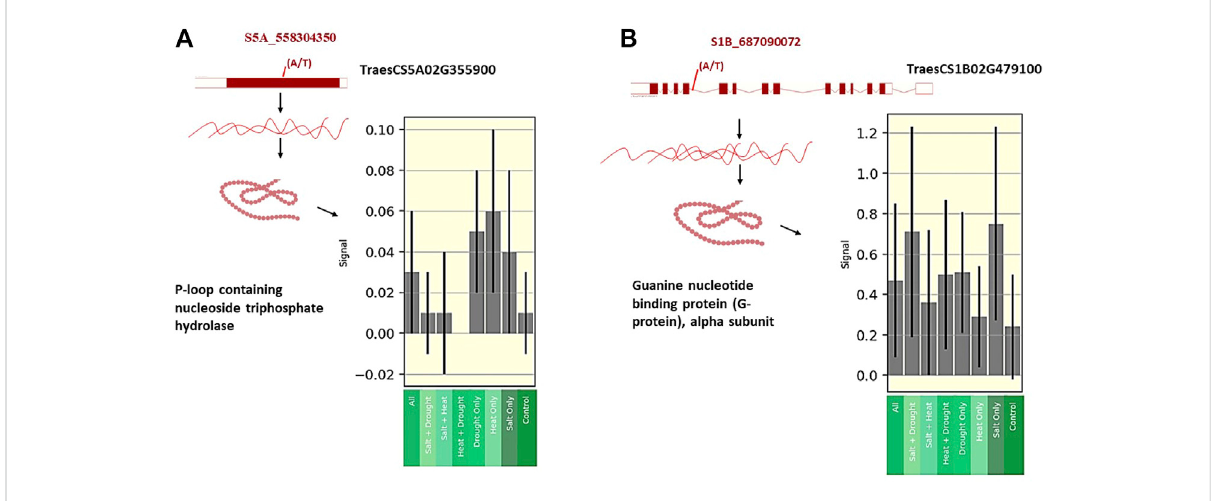
FIGURE 7 (A) Gene expression of TaesCs5AG355900 at fl ag leaf under different abiotic stress after heading date. (B) Gene expression of InesCS1B026479100 at fl ag leaf under different abiotic stress after heading